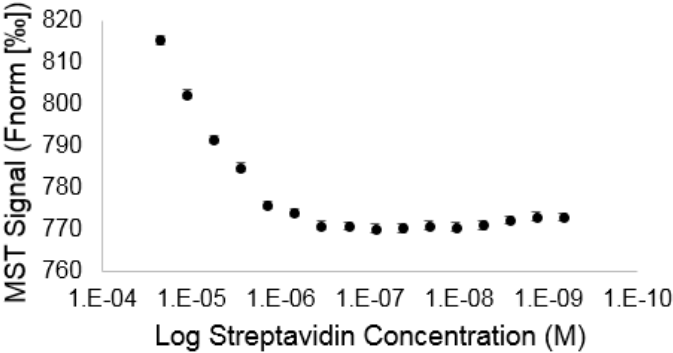
Figure 3. Microscale thermophoresis signals resulting from binding induced changes in hydration shell corresponding to distinct thermophoretic signals for the probe (IR783-VSHPQAPF) with increasing concentrations of streptavidin target.